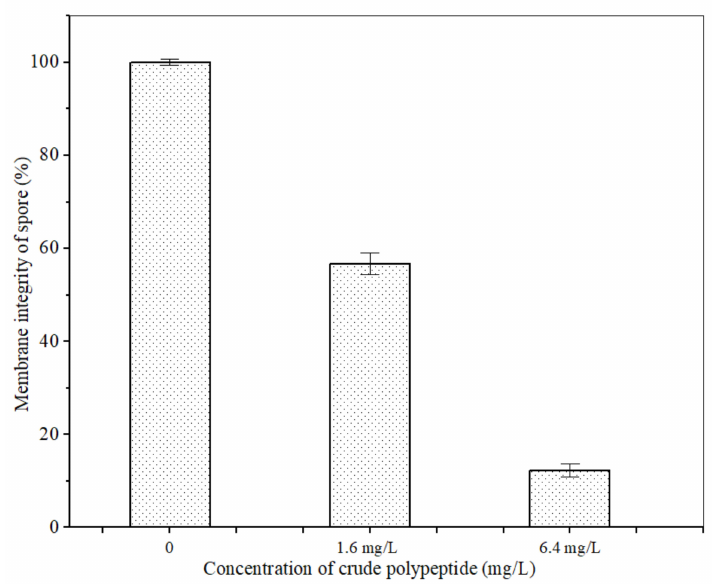
Figure 7. Effect of anti-fungal peptides on membrane integrity of A. carbonarius H9